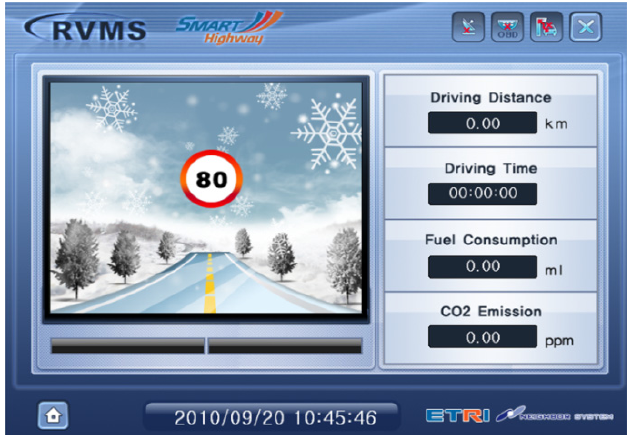
Figure 11. Example of a Telematics device with advisory speed and ice surface